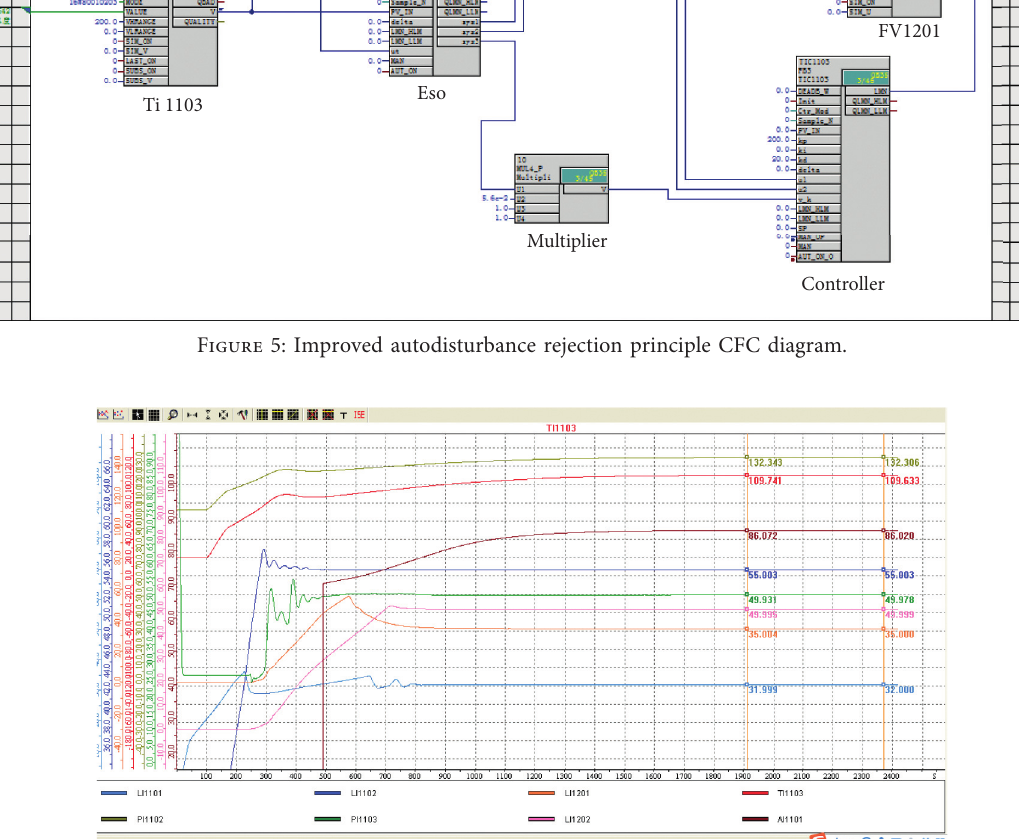
Figure 6: Trend graph of improved automatic disturbance rejection